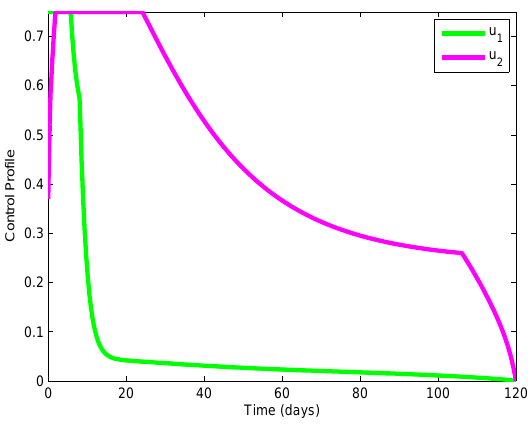
Figure 6: Efficiency of controls.